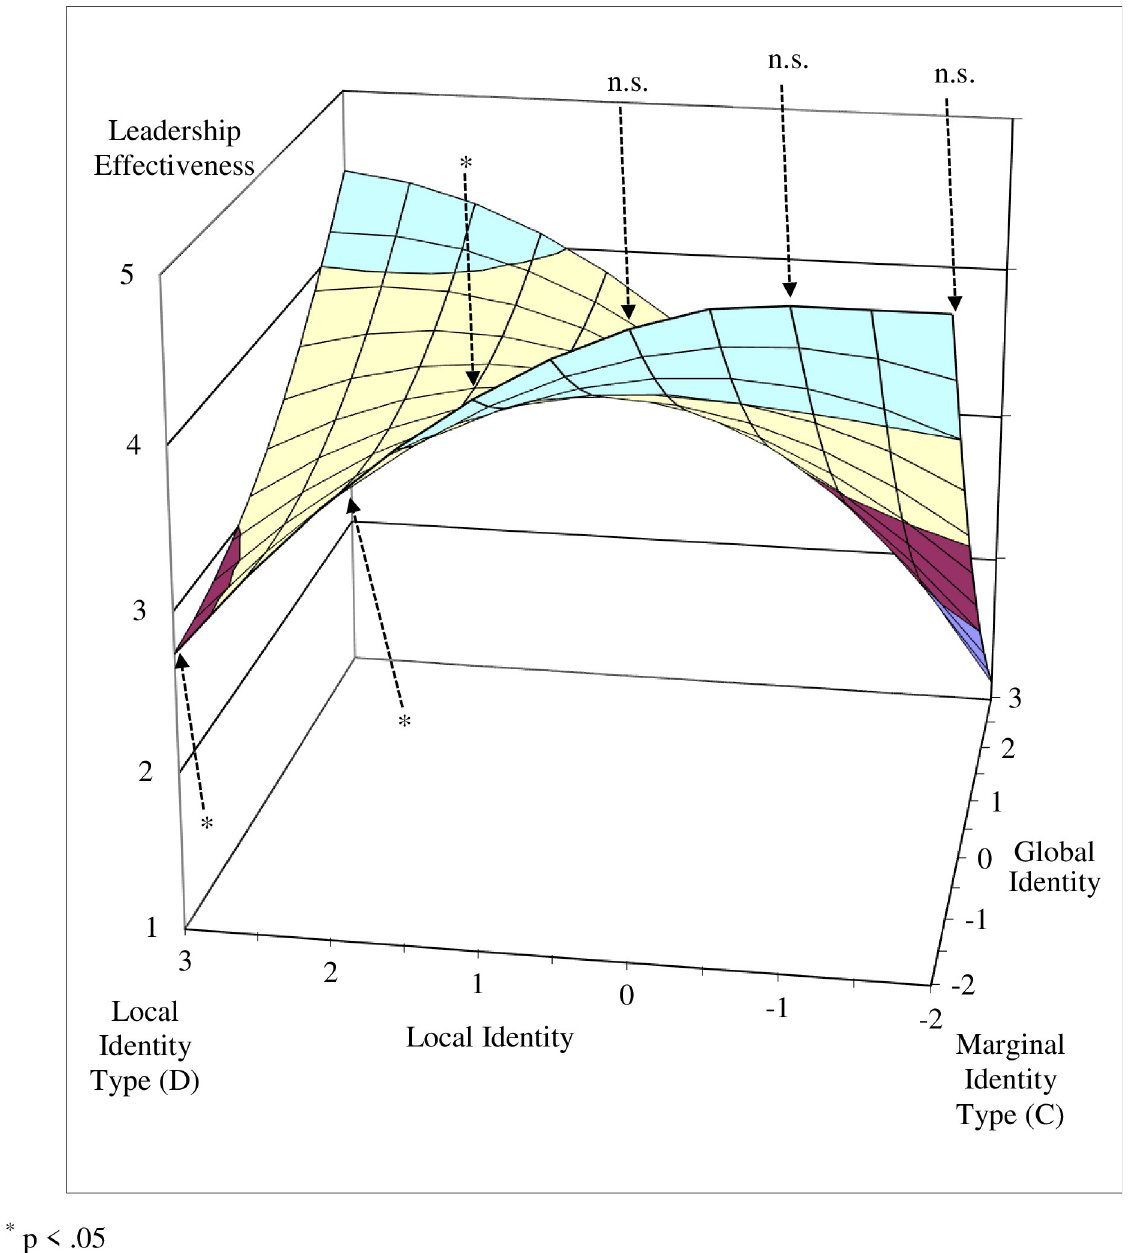
Fig 6. Tangent slope significance along the local–marginal line as predictor of leadership